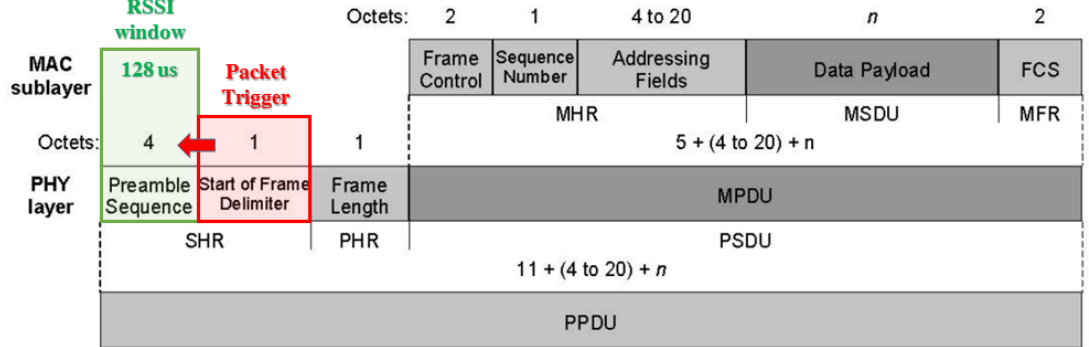
Figure 10. Pictorial of RSSI evaluation scheme within packet frame for IEEE